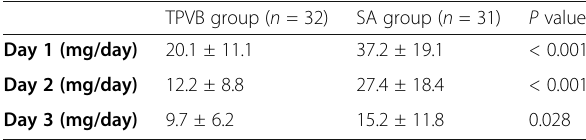
Table 4 Postoperative morphine consumption daily for each group